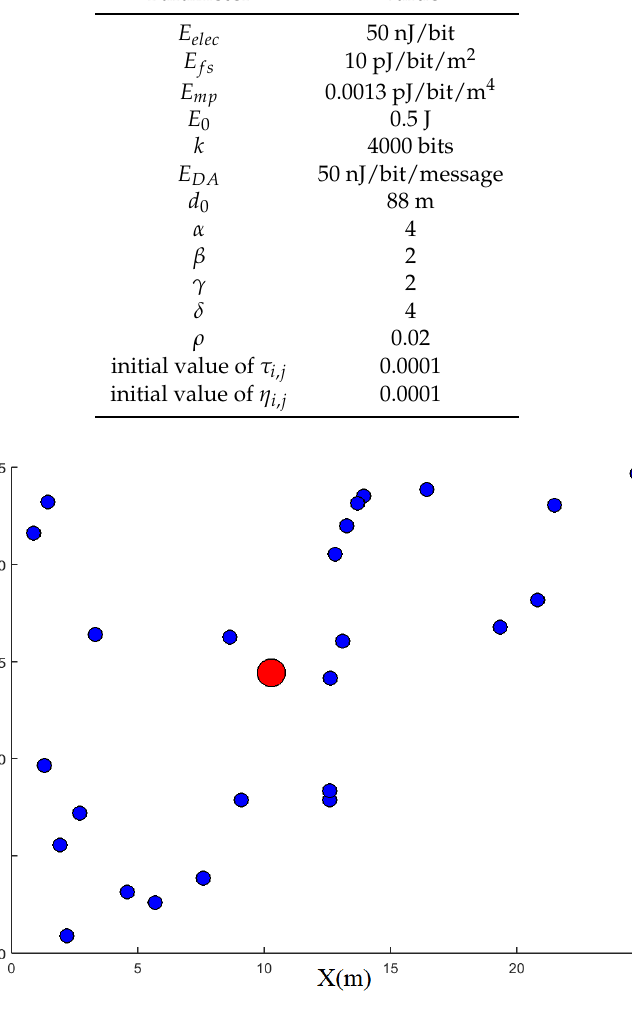
Figure 2. The sink in the middle and the nodes are scattered